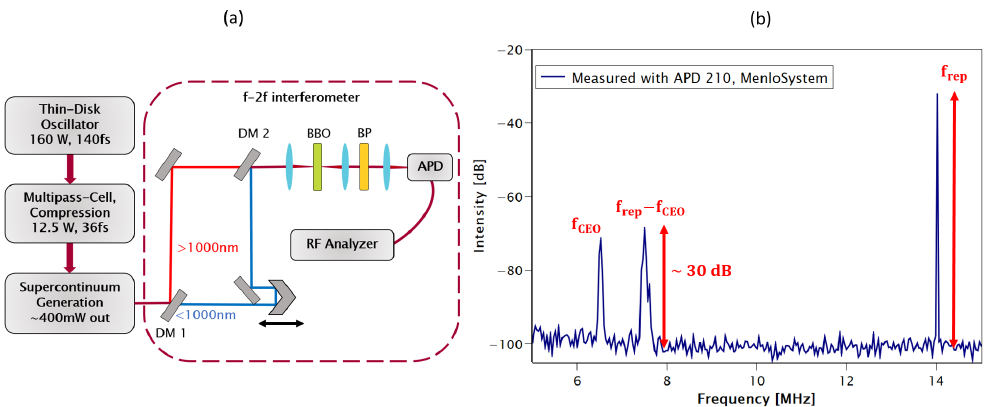
Fig. 1 (a): Schematic setup for the f-to-2f interferometer. DM: Dichroic mirror, BBO: Beta-Barium-Borate nonlinear crystal, BP: Bandpass filter at 720 nm, APD: avalanche photo-diode. (b): Beat signal and repetition rate with a resolution bandwidth of 10